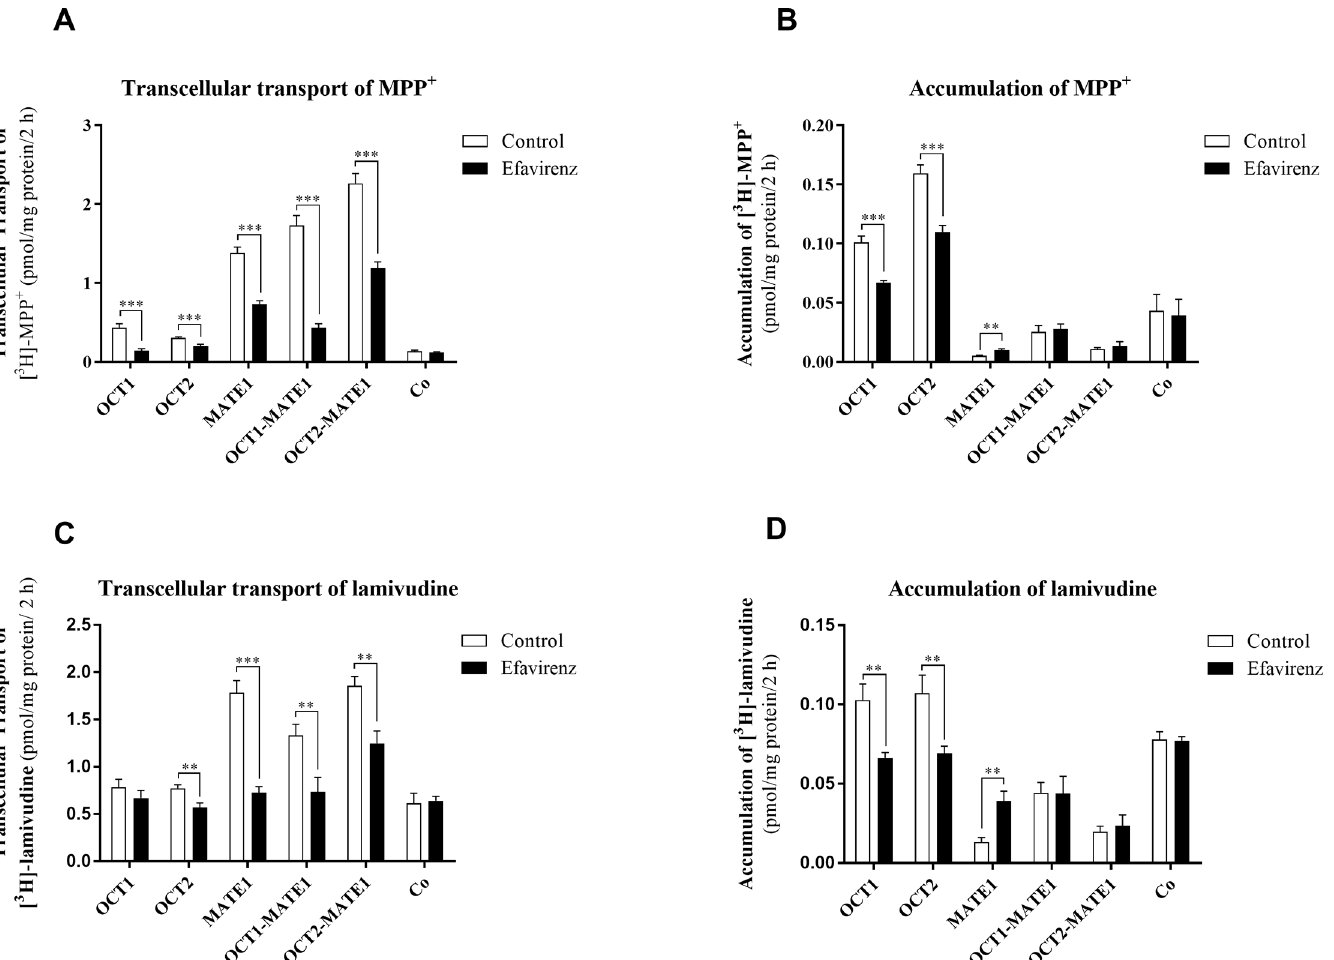
Fig 2. Effect of efavirenz (10 μ M) on transcellular transport of 2 nM[ 3 H]-MPP + (A) and 10 nM [ 3 H]-lamivudine (C) from the basal to the apical compartment, and intracellular accumulation of [ 3 H]-MPP+ (B) and [3H]-lamivudine (D) in monolayers of MDCK-OCT1, MDCK-OCT2,